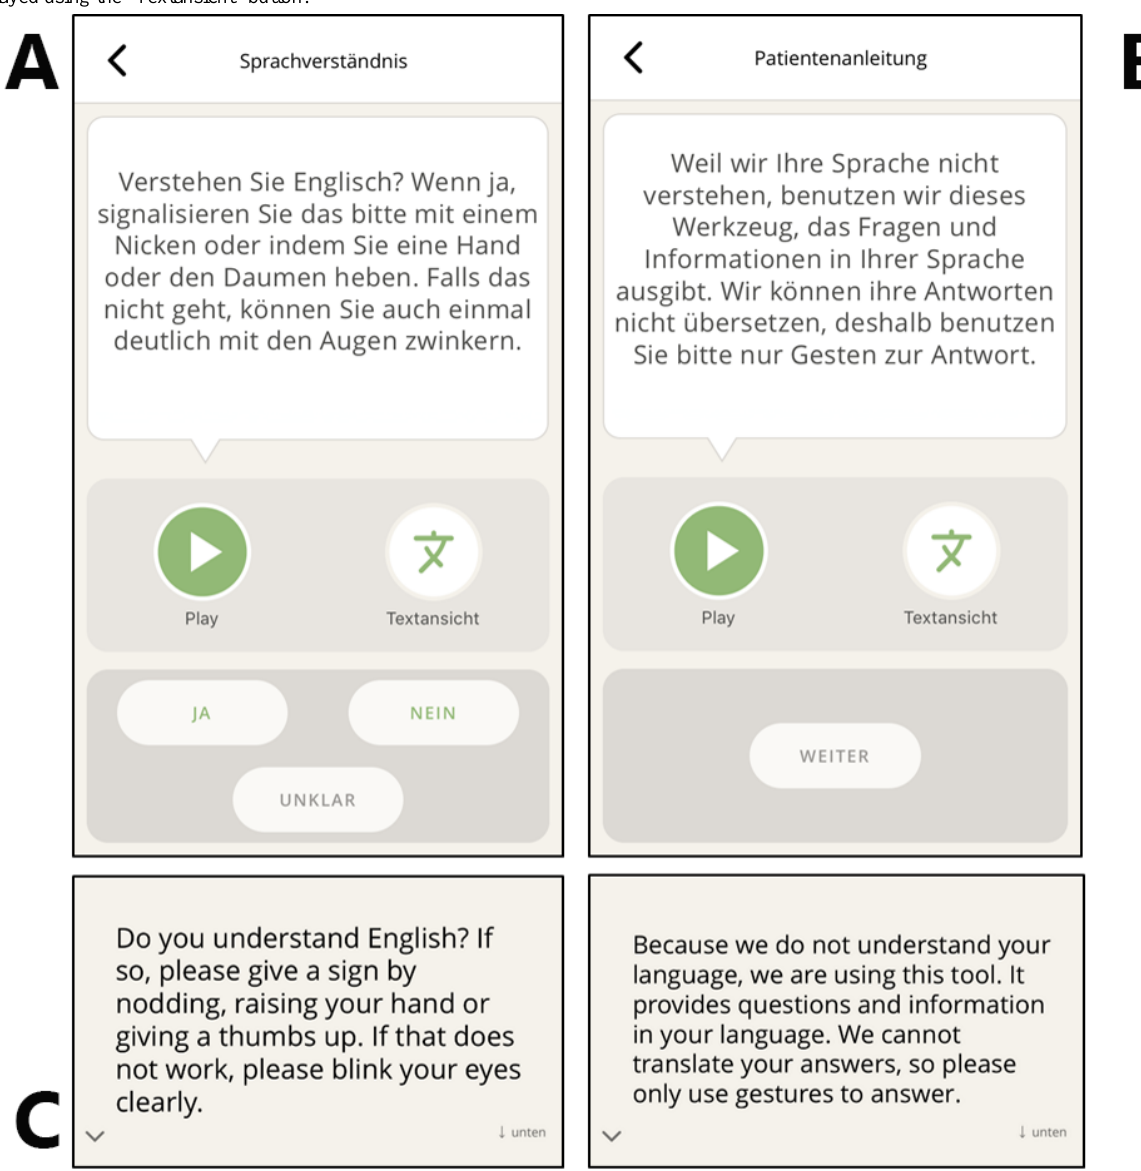
Figure 5. (A) To confirm that the patient understands the chosen language, the app may ask “Do you understand [chosen language]?” and asks the patient to sign “yes” if so. (B) The app provides a short explanation of the tool’s function to prevent misunderstandings. (C) The respective text is displayed using the “Textansicht”